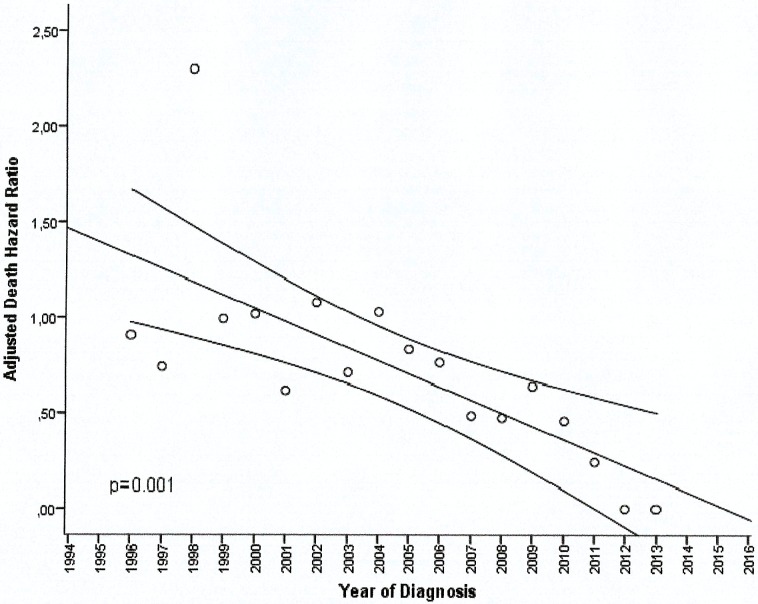
Adjusted death hazard rate to year of diagnosis for the Spanish Lymphoma Study.